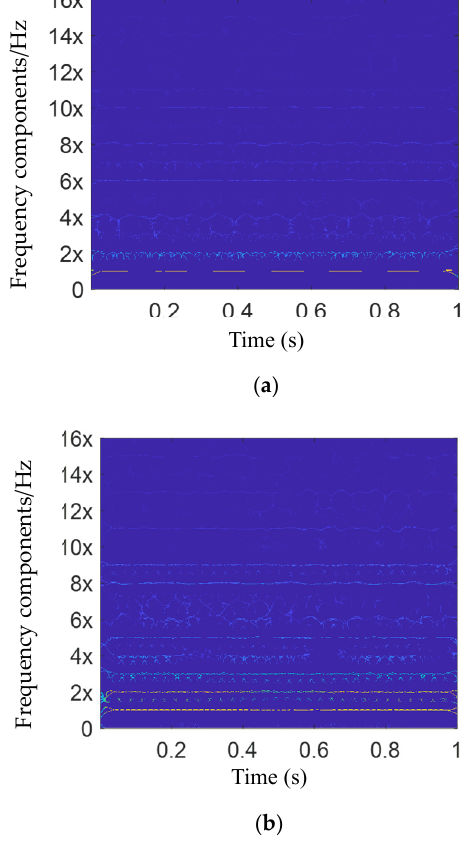
Figure 25. The RSECT for rubbing fault signals. ( a ) Slight rubbing ( b ) Serious rubbing